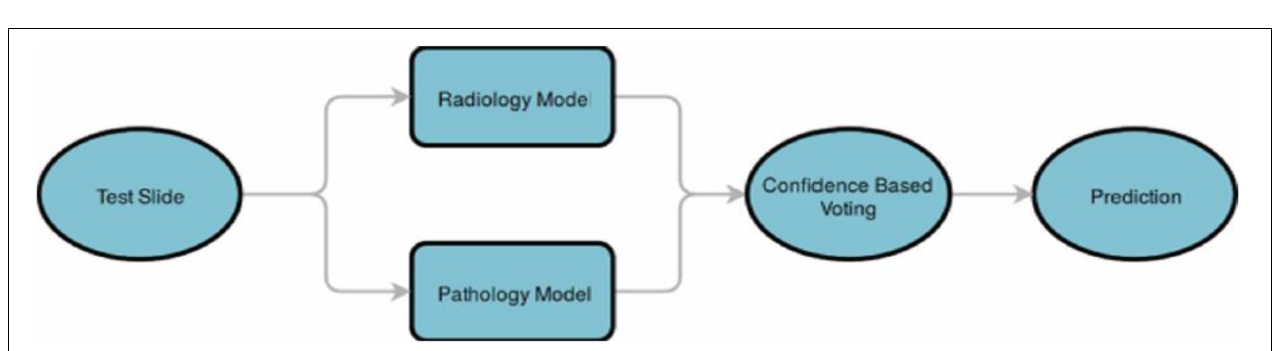
FIGURE 3 | Pathology image analysis. A region-of-interest (ROI) step detects and segments tissue regions. The tissue regions are partitioned into patches. Distinct patches are filtered using the isolation forest technique. The prediction represents the probability values of the case being astrocytoma or oligodendroglioma.